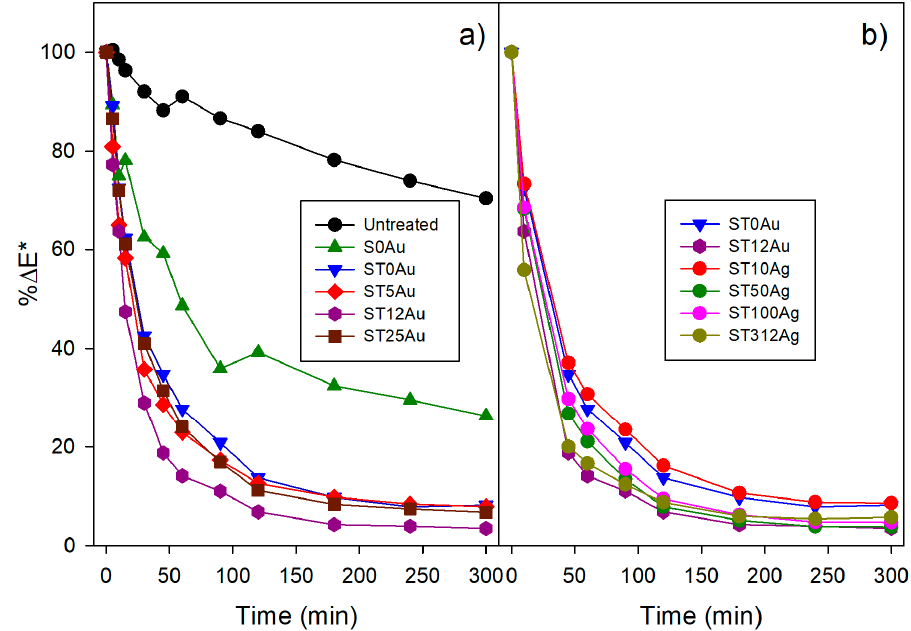
Figure 9. ( a ) Evolution of % Δ E * for the untreated and treated stone samples stained with methylene blue; ( b ) Comparison of results for ST and ST12Au, with the results obtained for the stones treated with different Ag-TiO 2 /SiO 2 products.